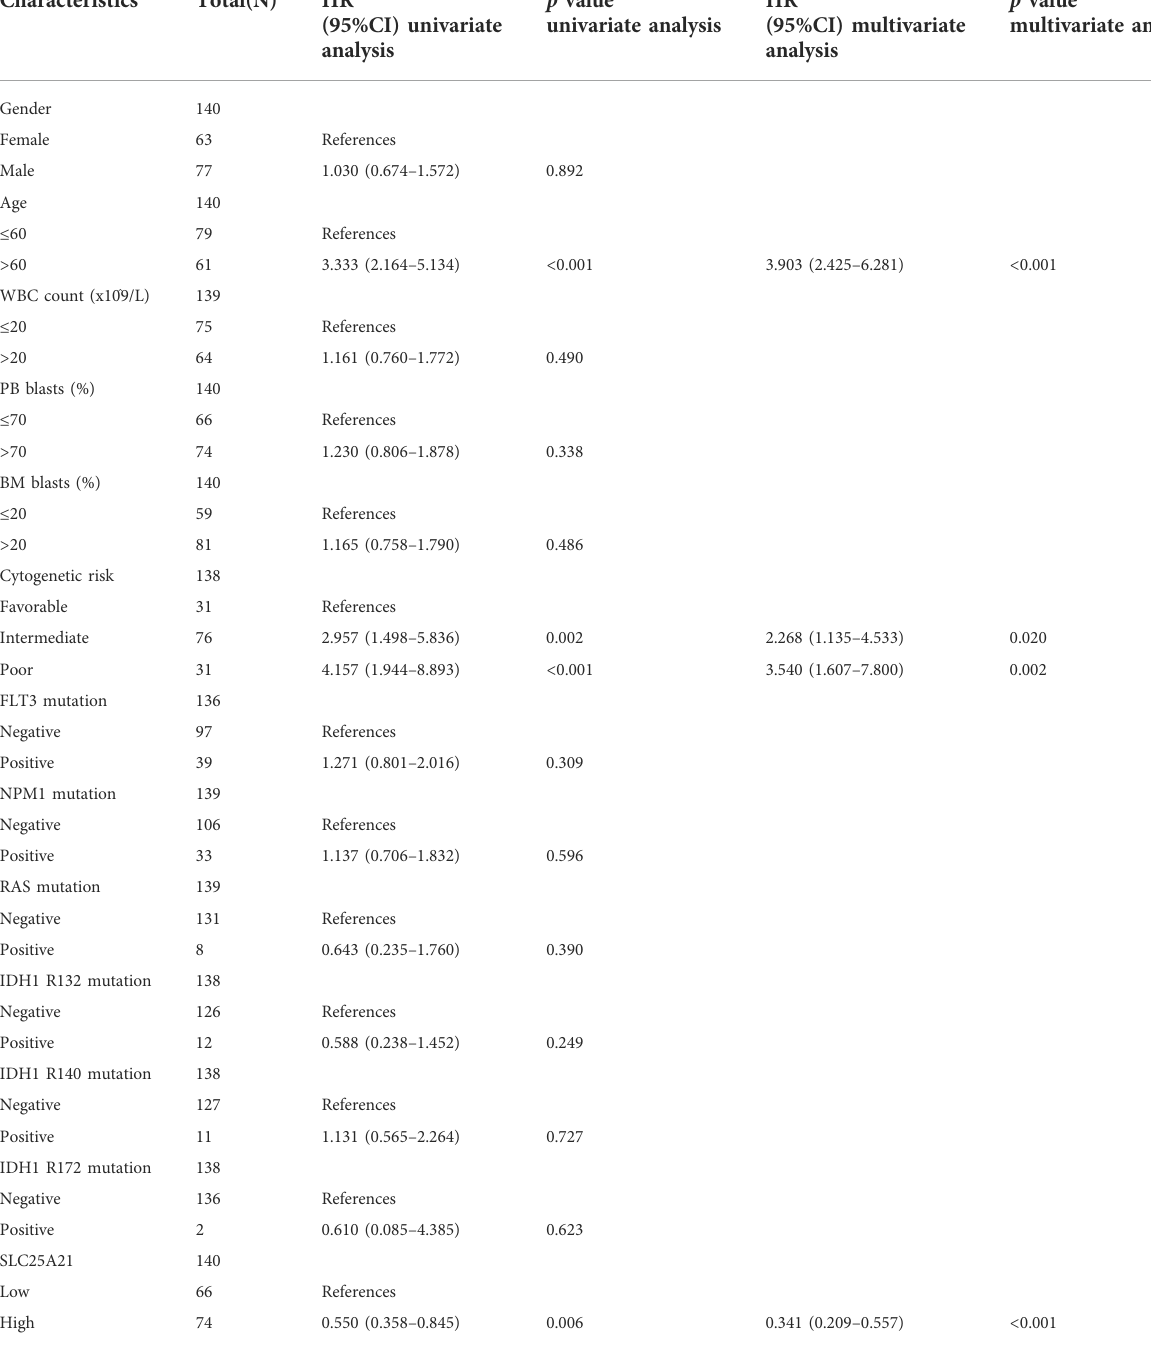
TABLE 1 Clinical characteristics of AML patients with differential SLC25A21 expression levels.